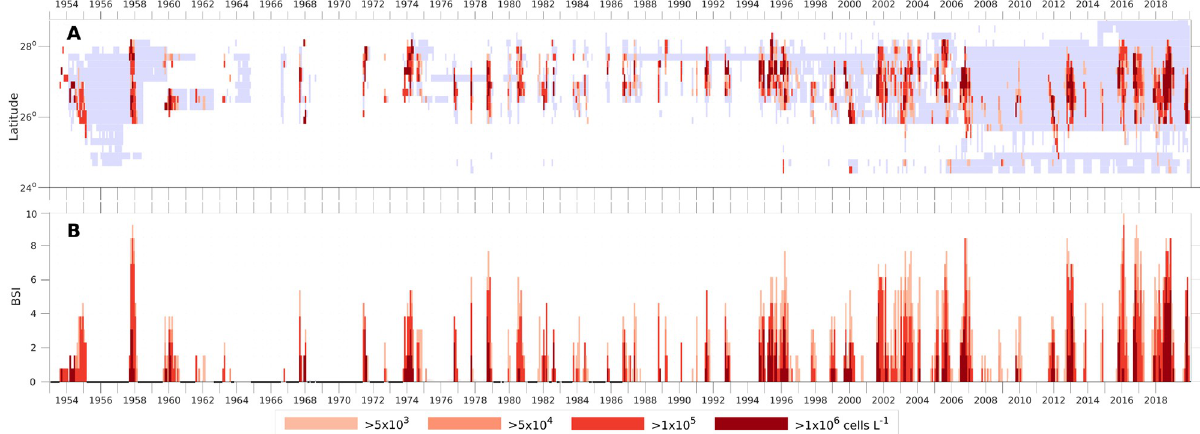
Fig 2. Monthly binned maxima and bloom severity index for K . brevis . (A) Hovmo¨ller (time-latitude) diagram for the 0.2 degree latitude-binned monthly-maxima of observed K . brevis cell counts within 5 km (3 mile) offshore of the coast during 1953–2019. (B) The bloom severity index (BSI) for southwest Florida [25.4˚-28.4˚ N] for each month determined by adding the bins for each class from the data in (A) and normalizing (more details in Section 2.1). For each bin and stack, the maximal cell count was determined and classified into five categories: < 5,000 (light blue gray), > 5,000 > 50,000 > 100,000 and > 1,000,000 cells L -1 (salmon color to dark red). In panel (A) white indicates “no sample”, in panel (B) thicker black on the X-axis indicate months without cell count observations in the region; these occurred at intervals between 1953 and 1986. The greater the contribution of the darker colored segments to the overall height of the combined scaled values in any given month, the greater the extent of maximal cell count present.